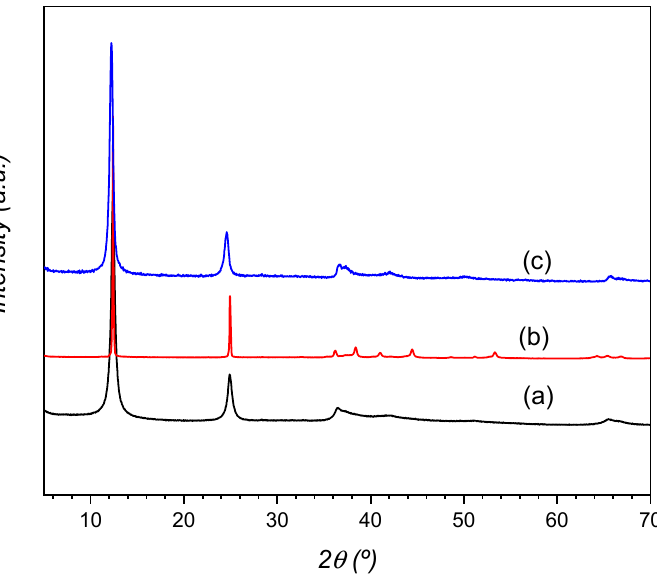
Figure 1. XRD patterns of (a) KMn4, (b) KMn8 and (c) HKMn. Table 1 gathers relevant crystallographic data obtained from Rietveld refinements of XRD data for KMn8 and HKMn. The corresponding profiles are shown in Figure 2. The structural models for both samples are also included (insets), evidencing the differences between them. Whereas the unit cell of KMn8 can be described as two-layer hexagonal (2H), the HKMn unit cell is three-layer hexagonal (3H). Thus, the close-packing notation